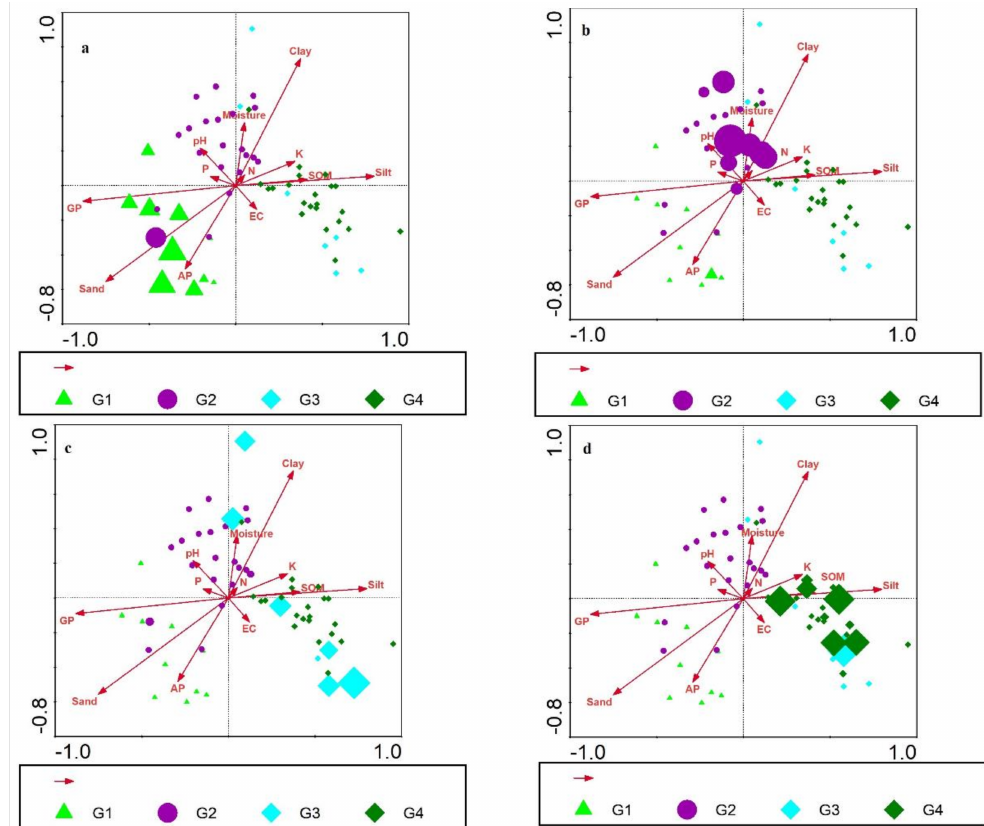
Figure 6. Data attribute plot of indicator species in four groups of climber plants. a. Cissampelos pareira ; b. Galium aparine ; c. Ipomoea purpurea ; d. Pentatropis nivalis. The arrows represent the environmental variables, while the quadrats in four groups are represented by different colors. The size of samples depicts the density of each indicator species in different